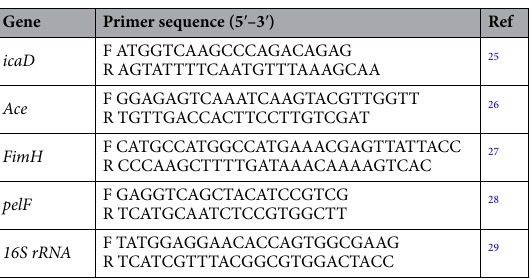
Table 2. The primer sequences of biofilm-related